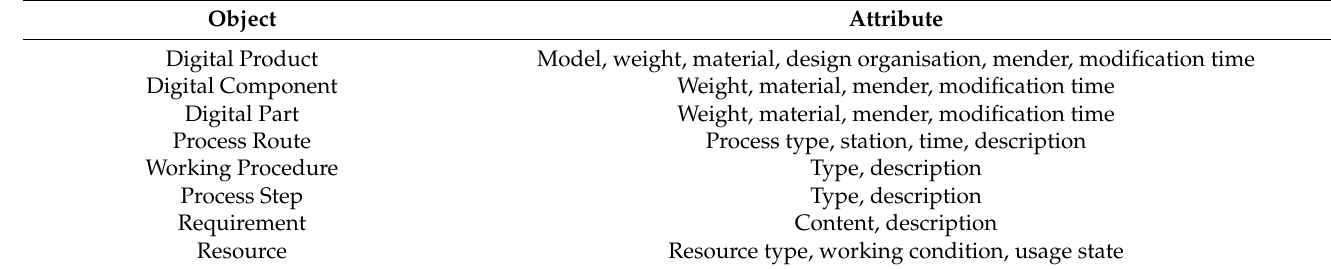
Table 2. Attributes of digital object.